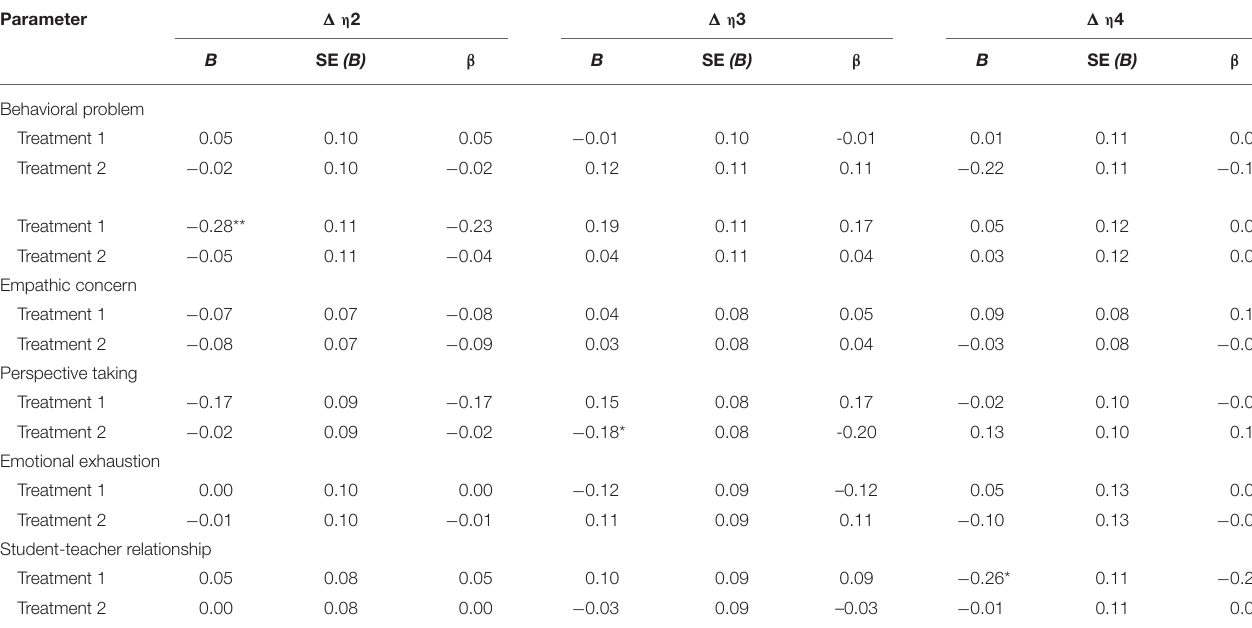
TABLE 4 | Results from LCS modeling (study